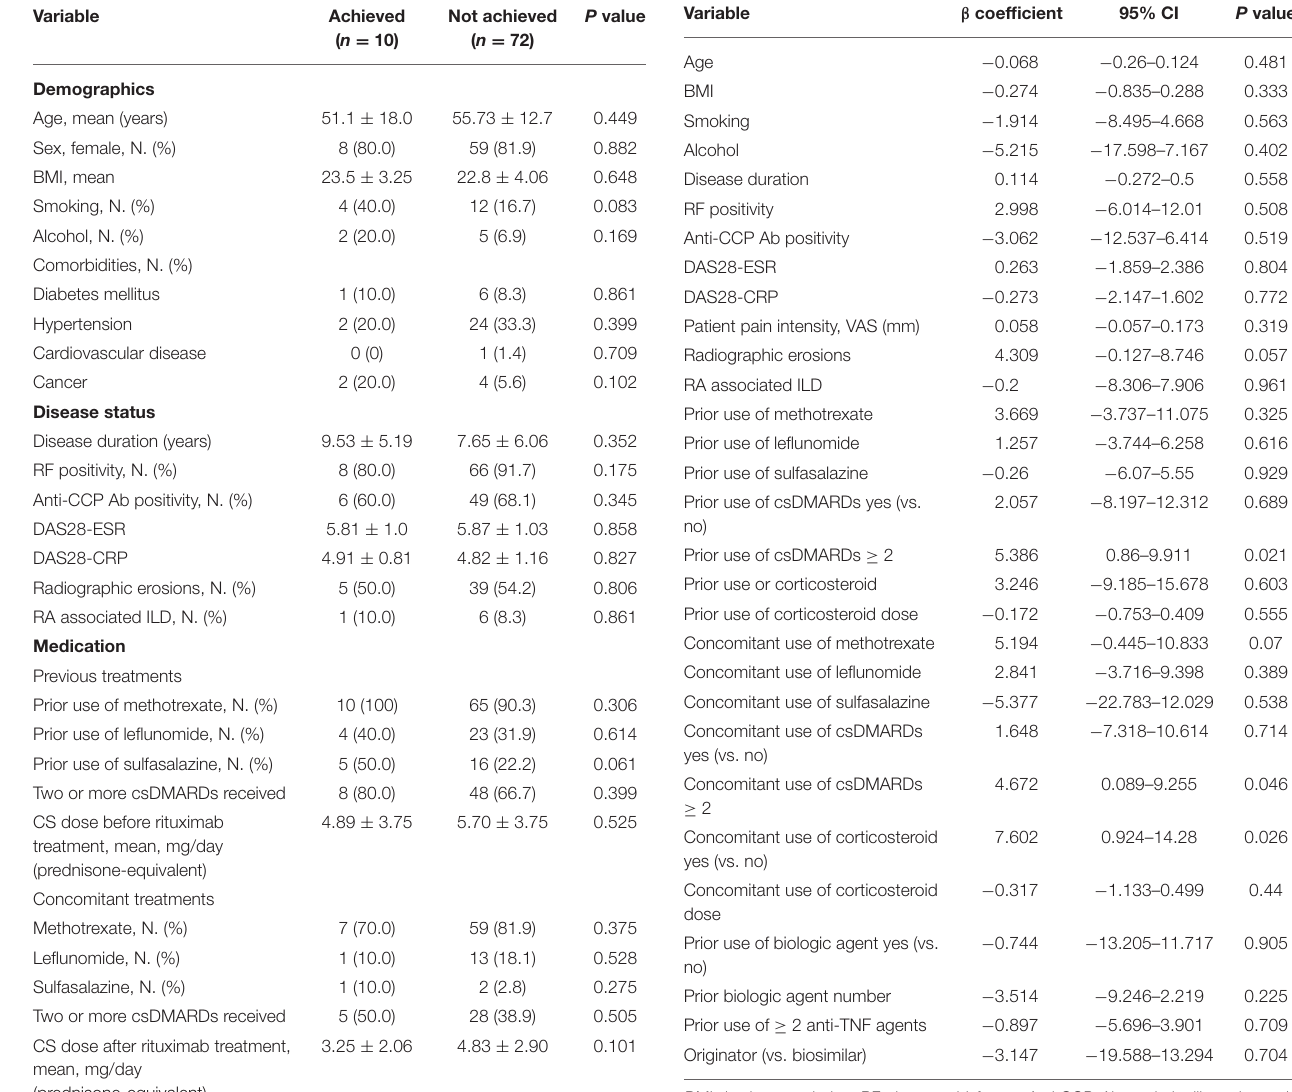
TABLE 4 | Factors related to extending the time intervals between rituximab